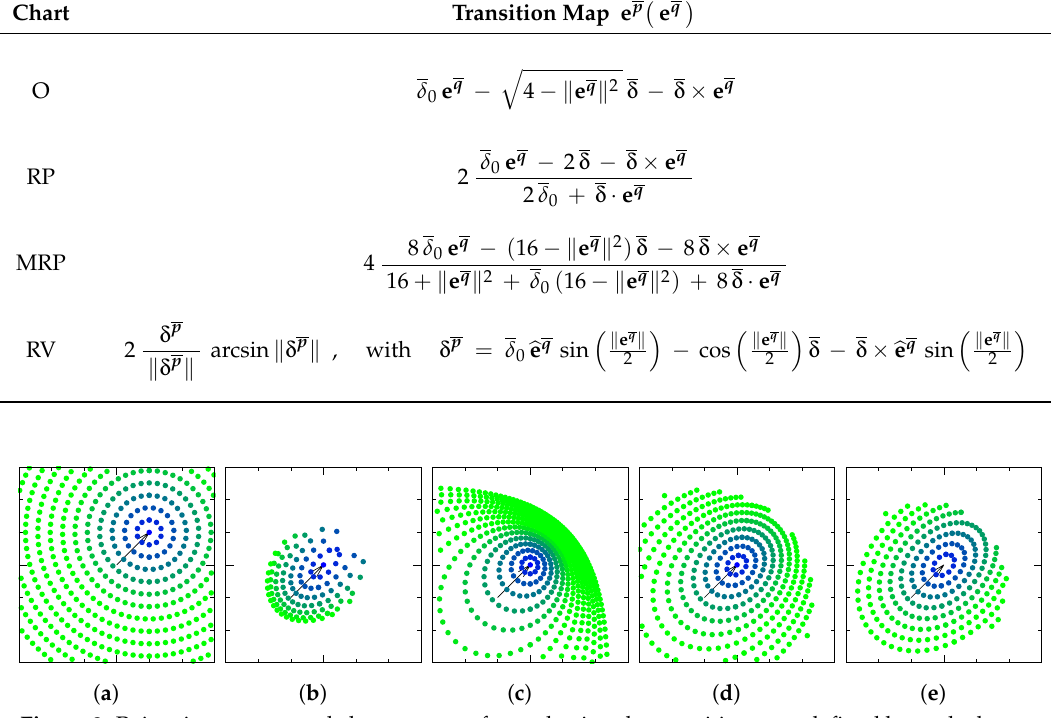
Figure 3. Points in a q -centered chart are transformed using the transition map defined by each chart, and travel to the chart centered in the quaternion mapped with e q = ( 1,1,0 ) T in the previous chart. ( a ) R 2 ; ( b ) O; ( c ) RP; ( d ) MRP; ( e )